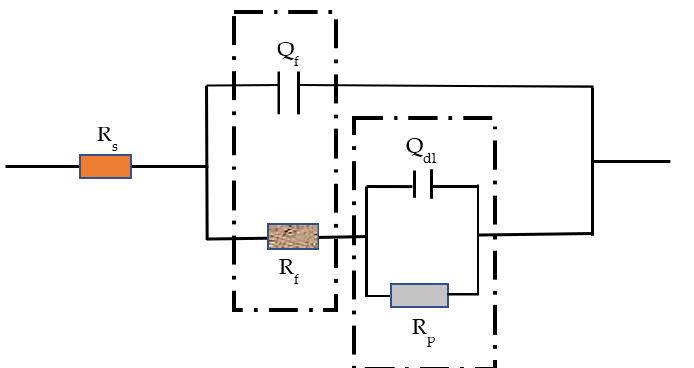
Figure 5. Equivalent circuit diagram.